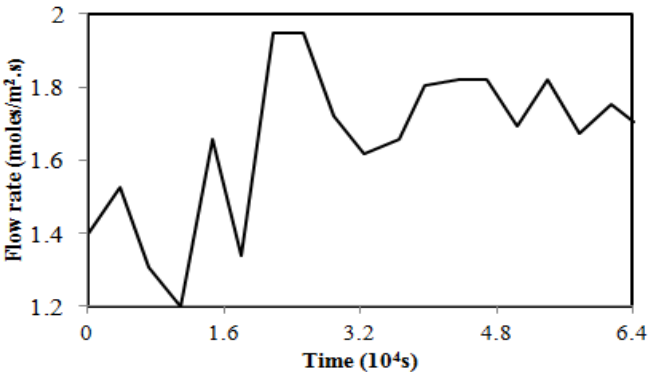
Figure 10. Flow rate of the injected air with time [43].